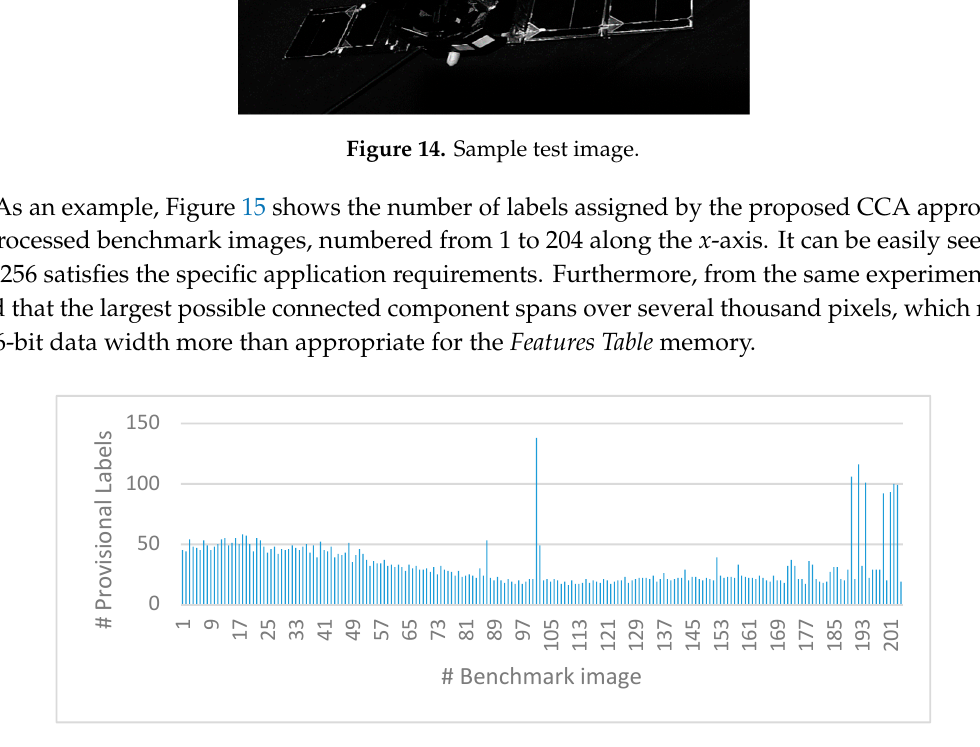
Figure 15. Number of provisional labels assigned by the proposed algorithm to the examined image dataset.